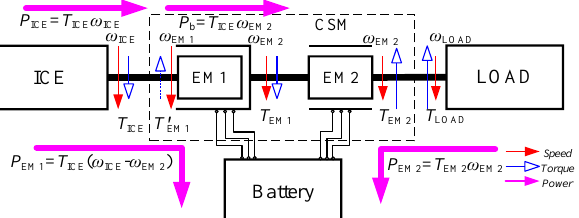
Figure 3. Analysis of power flow in engine-motor coordinated braking (EMCB) mode.